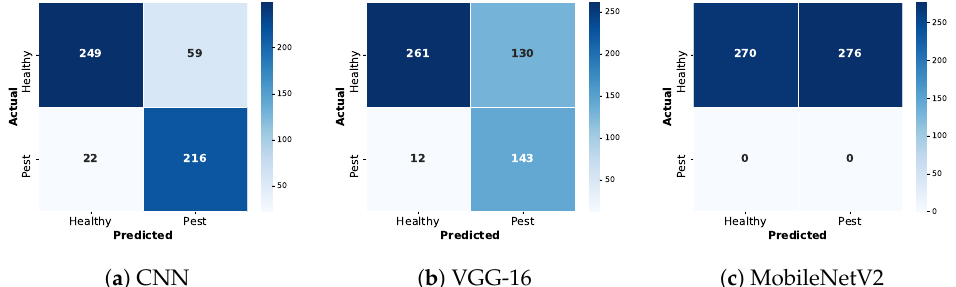
Figure 7. Confusion matrices on a pest pattern based on 546 validation